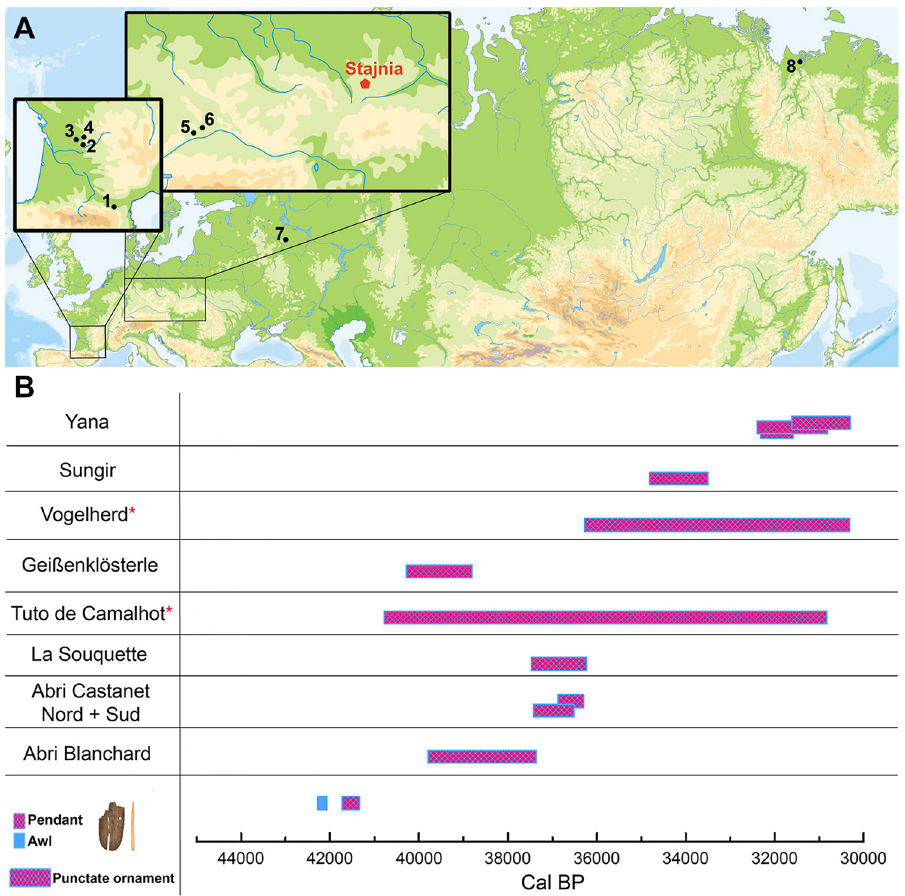
Figure 4. Map of the geographical distribution of the sites where punctuated ornaments and objects have been found. ( A ) Map of the geographical distribution of the sites where punctuated ornaments and objects with punctate decoration have been found in Aurignacian and Early Upper Palaeolithic contexts (1 Tuto de Camalhot, 2 Abri Blanchard / Abri Castanet, 3 Abri la Souquette, 4 Abri Lartet, 5 Geißenklösterle, 6 Vogelherd, 7 Sungir, 8 Yana); ( B ) Chronological comparison of Stajnia pendant and awl (calibrated ranges) with other artistic punctate ornaments found in Upper Palaeolithic sites (modelled ranges). The horizontal bars show the calibrated ranges of direct dates of the awl in blue and of the pendant in pink cross-hatched. From the other sites, the age range of the layers where punctate ornaments have been found are pink cross-hatched bars and are the modelled date ranges produced using the ’date’ command in OxCal (See Table S14). The red asterisk close to the name of the sites indicates a ’hypothetical’ boundary imposed by the Bayesian model due to a very low agreement index for Vogelherd and just two samples out of context for Tuto de Camalhot. All the bars represent 68.3%